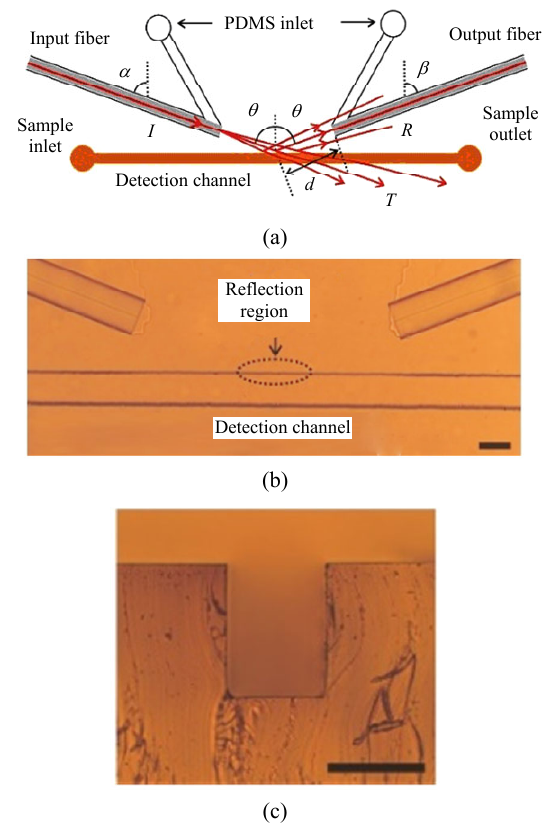
Fig. 2 Illustration of a microfluidic RI sensor: (a) a schematic illustration of a microfluidic RI sensor with one pair of fibers for optimizing the tilting angles of the input fiber and the distance between the end face of the output fiber to the reflection zone and (b) optical micrograph of a microfluidic RI sensor with  =  =71°, and d =0.6 mm, and (c) cross section of the detection channel. Scale bars: 125 